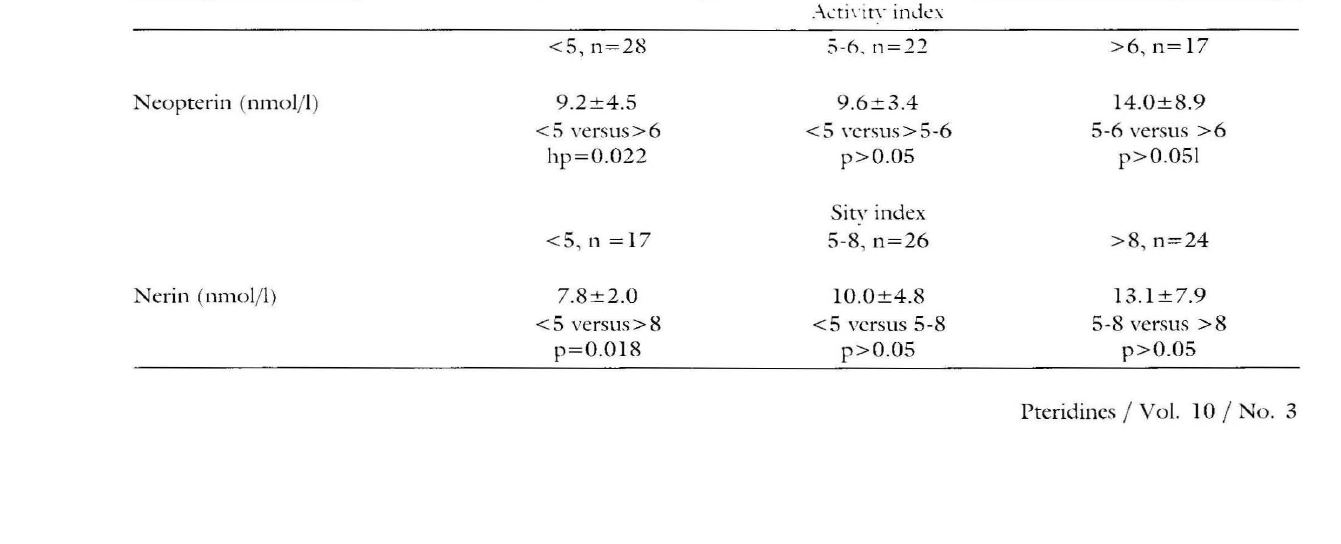
Table 4. Serum concentrations of neoptcrin .lc«)rdin~ [.) c~i,c."L· .ldl\ :r." .1I1el 'c\"crir\' incii(c, in f"lticl1t~ \\'ith rhcumatoid